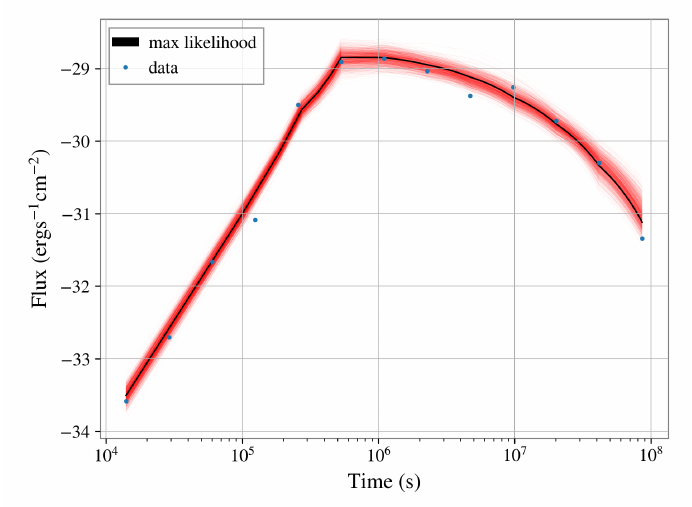
Figure 3. Injection data points (blue) overlaid with the best-fit power-law jet model (black solid line). Red lines are 1000 random draws from the posterior samples.